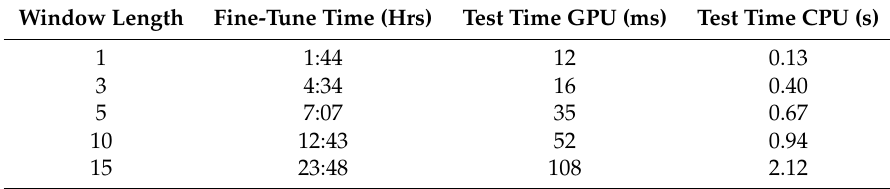
Table 5. The fine-tuning time and test times for the networks using different window lengths. The network with window length 1 is the implementation of BIM-PoseNet for comparing times. Window Length Fine-Tune Time